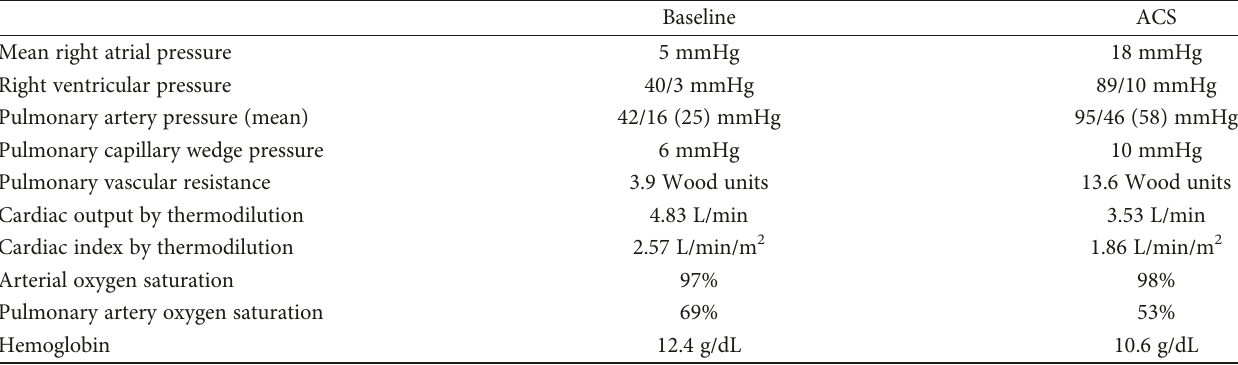
Figure 1: Apical four-chamber views and abbreviated echocardiogram reports from the baseline, acute chest syndrome (ACS), and follow-up. (a) Baseline echocardiogram. Twenty-two months prior to ACS. Left ventricular ejection fraction 55-60%. Moderately enlarged right ventricular chamber with mildly reduced systolic function. Mild right atrial enlargement. Moderate tricuspid regurgitation. Pulmonary artery systolic pressure 60 mmHg plus central venous pressure. Inferior vena cava small and collapses with inspiration. (b) Echocardiogram during ACS. Left ventricular ejection fraction 60-65%. Severely enlarged right ventricular chamber with moderately reduced systolic function. Severe right atrial enlargement. Severe tricuspid regurgitation. Pulmonary artery systolic pressure 132 mmHg plus central venous pressure. Inferior vena cava dilated. (c) Follow-up echocardiogram. Ten months after ACS. Left ventricular ejection fraction 55-60%. Moderately enlarged right ventricular chamber with moderately reduced systolic function. Moderate right atrial enlargement. Moderate tricuspid regurgitation. Pulmonary artery systolic pressure 45 mmHg plus central venous pressure. Inferior vena cava normal in caliber and collapses with inspiration. Table 1: Hemodynamics on right heart catheterization nineteen months prior to hospitalization (baseline) in comparison to during acute chest syndrome